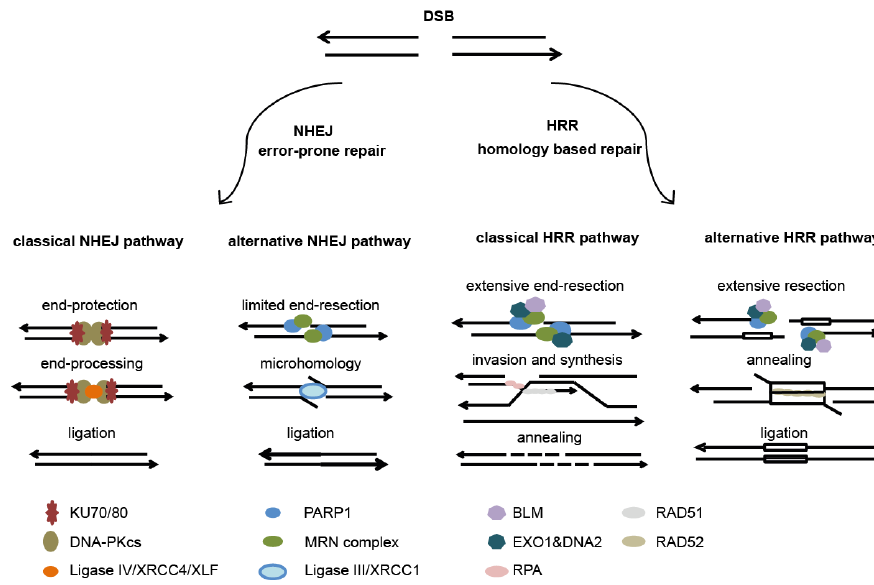
Figure 3. A short overview of DNA double strand break (DSB) repair mechanisms.